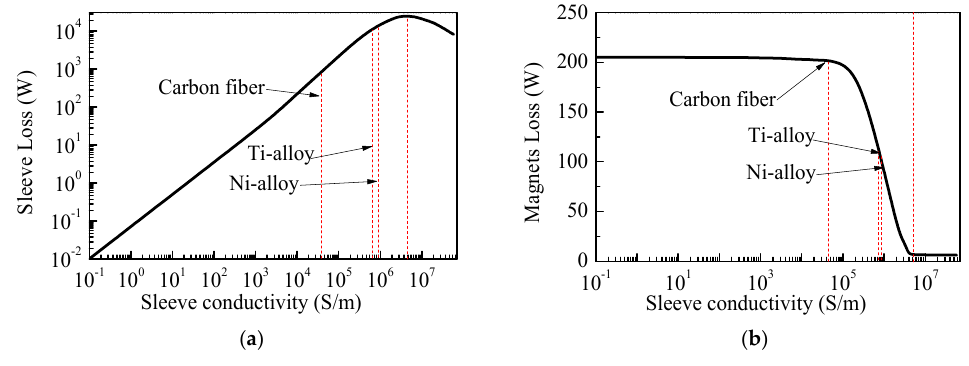
Figure 4. Influences of conductivity of the sleeve materials on ( a ) sleeve loss; ( b ) magnet loss.